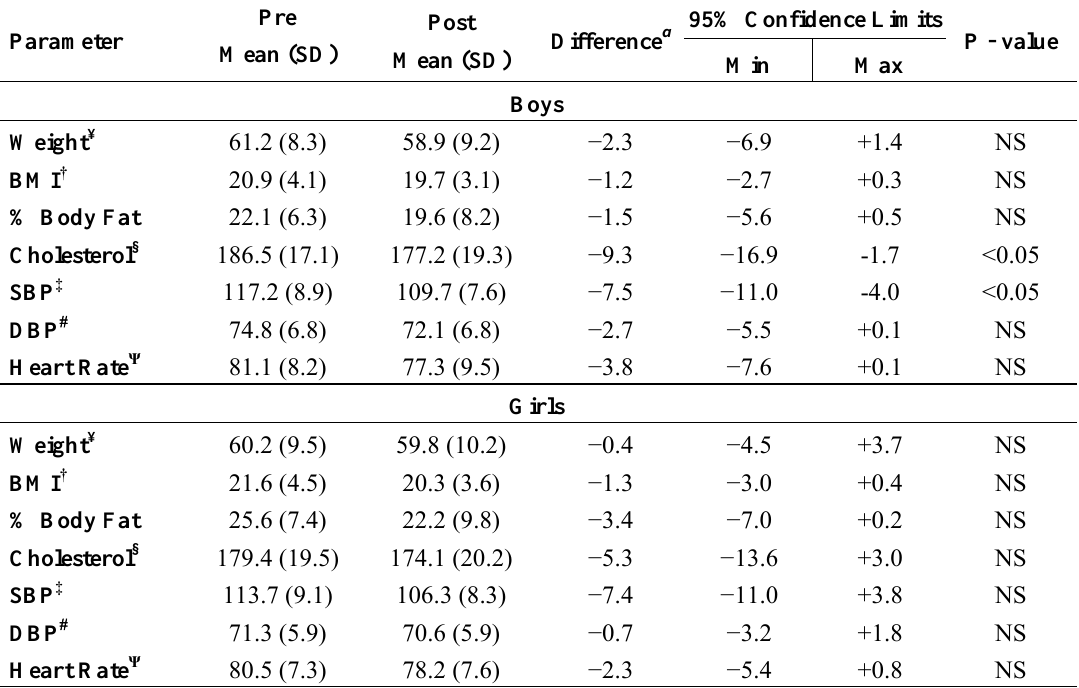
Table 4. Pre and post-intervention anthropometric and physiological parameters of intervention pupils by